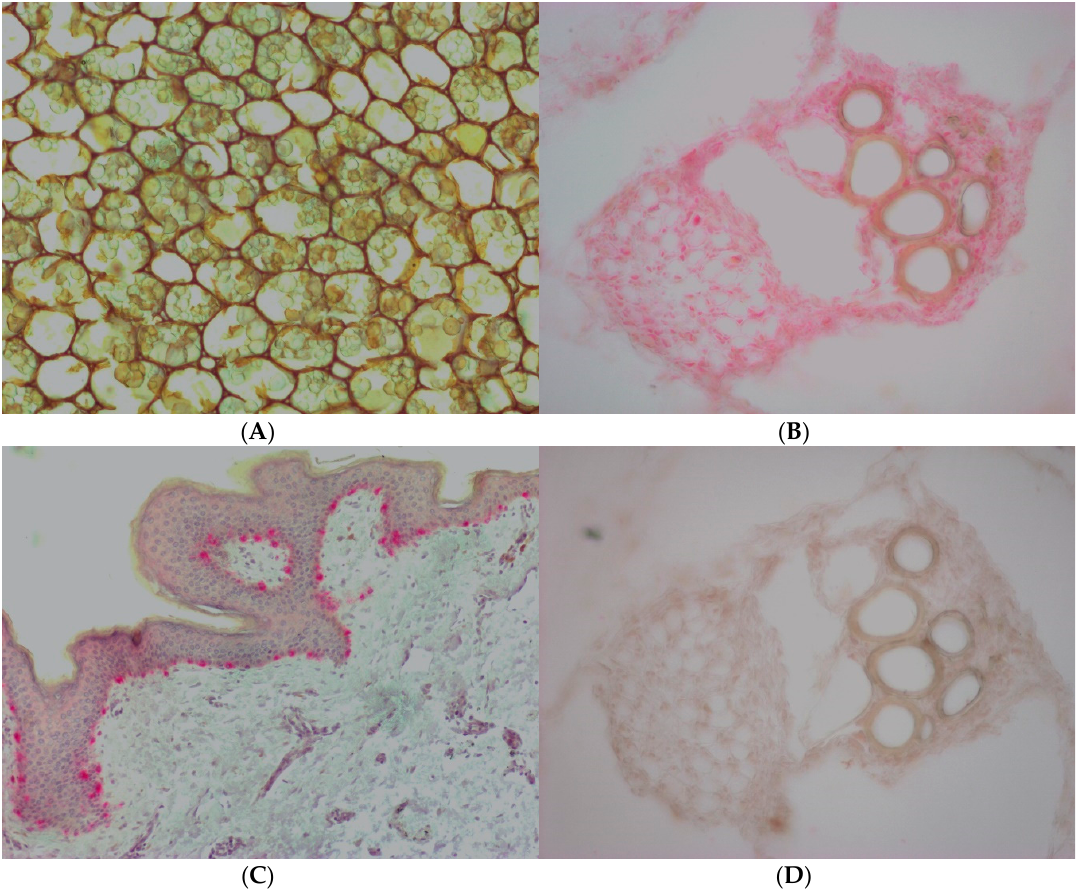
Figure 2. Immunohistochemical detection of PPO in Cynomorium coccineum , giant fennel, and human skin. ( A ) C. coccineum ; ( B ) and ( D ) giant fennel; ( C ) normal human skin. While the immunoreactivity for PPO in C. coccineum was absent ( A ), a marked immunostaining, identifiable as a reddish product, was observed in sections of both giant fennel ( B ) and human skin ( C ). In the negative control ( D ), the immunoreactivity was completely abolished. Original magnification: ( A , C ): ×100; ( B , D ) ×200. To verify whether the absence of the PPO catalytic activity and the failure of its immunohistochemical detection was linked to the absence of the coding gene or to its lack of expression, we isolated RNA and DNA and searched for the related nucleotide sequence.